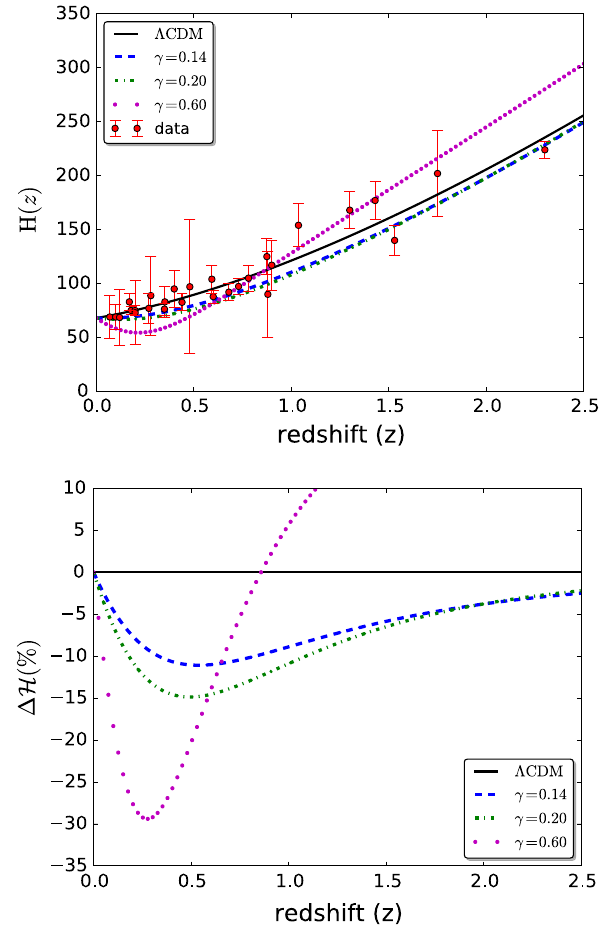
Fig. 18 Upper panel Hubble parameter in comparison with various observational values for H ( z ) . Lower panel relative difference of dimensionlessHubbleparameterasafunctionoftheredshiftforvarious values of the viscosity